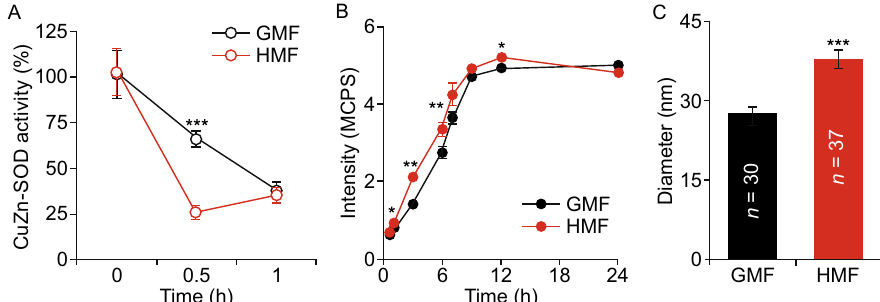
Figure 5. The HMF inhibits the activity of CuZn-SOD by inducing protein aggregation. (A) The activity of CuZn-SOD decreased faster in the HMF than the GMF ( n = 9). (B) Rayleigh scattering assay showed that larger protein aggregates were formed in the HMF ( n = 3). (C) AFM indicated that the size of protein aggregation was larger after 30 min HMF exposure ( n = 37) than the controls ( n = 30). CuZn-SOD was dissolved in water. n is the total number of samples from three independent experiments. Data were shown as mean ± s.e.m. The P values were calculated using one-way ANOVA. * P < 0.05, ** P < 0.01, *** P <